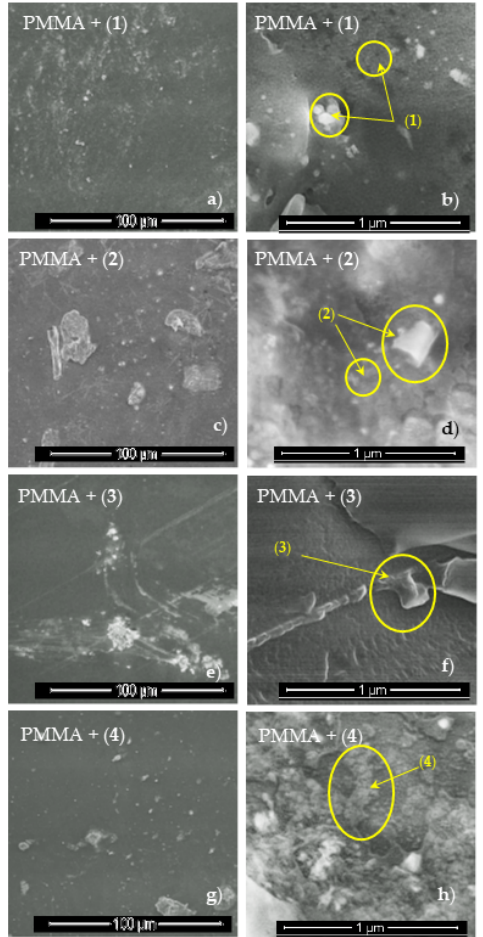
Figure 5. SEM images of PMMA + TOCs composites in different magnifications ( 1 ) ( a,b ), ( 2 ) ( c,d ), ( 3 ) ( e,f ), end ( 4 ) ( g,h